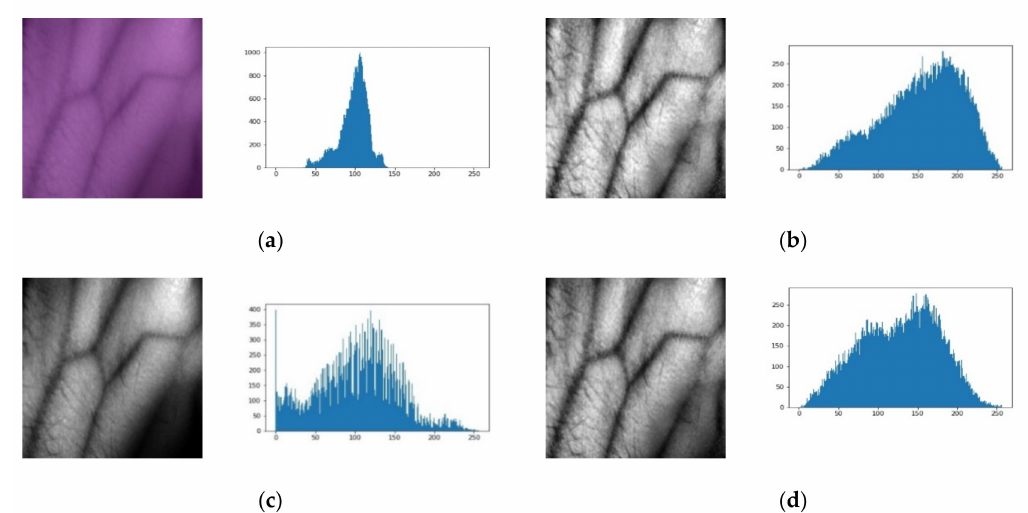
Figure 7. Result of each step of the proposed method with its corresponding histograms for the SUAS database. ( a ) Original dark contrast image. ( b ) After applying CLAHE. ( c ) After applying FAG. ( d ) CLAHE and FAG after applying improved weighted average